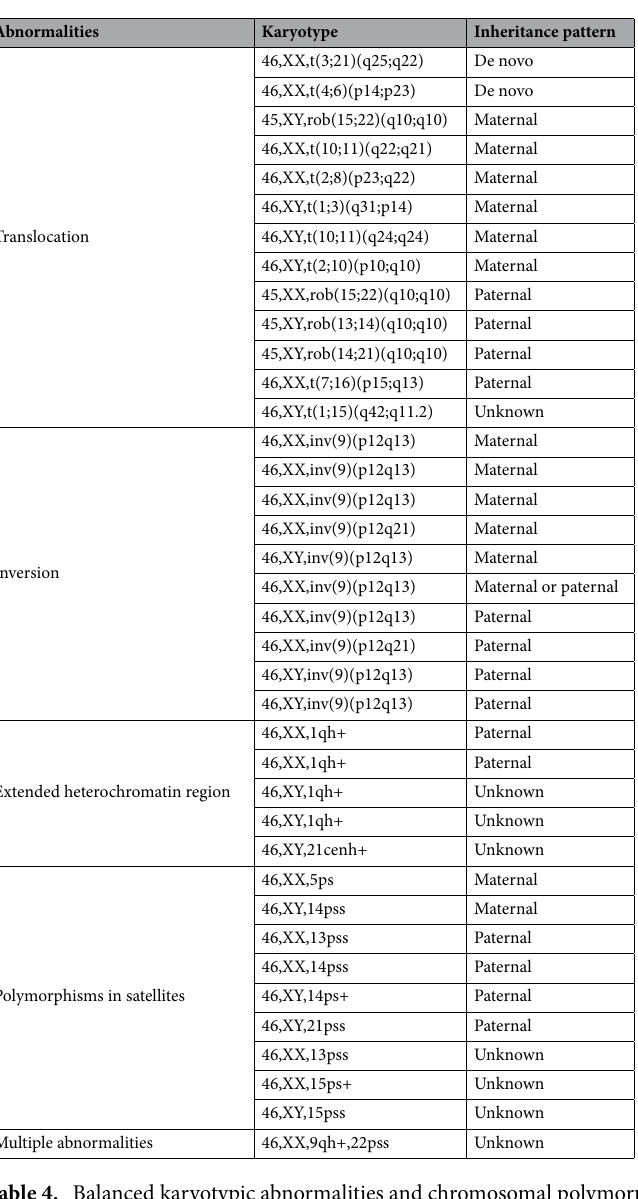
Table 4. Balanced karyotypic abnormalities and chromosomal polymorphisms detected in the karyotyping group.